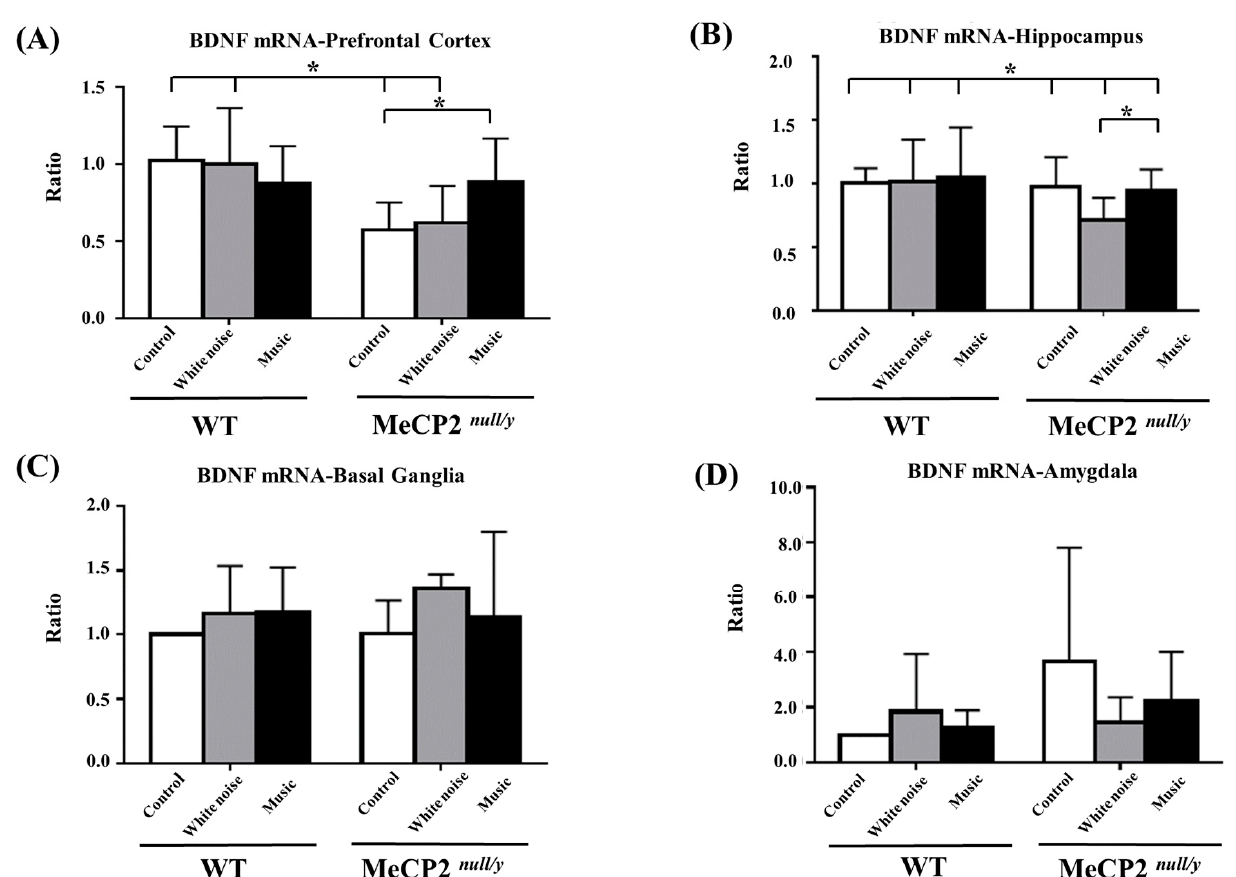
Figure 2. Comparison of BDNF mRNA expression between wild-type mice and mecp2 null/y mice in different brain regions. ( A ) Prefrontal cortex, ( B ) hippocampus, ( C ) basal ganglia, ( D ) amygdala (* p < 0.05).